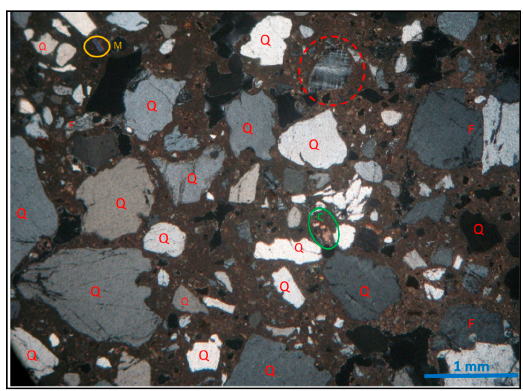
Figure 7. Micrography of sample S-004 (2.5×). Mineral abbreviations: Q: quartz; C: calcite; F: feldspar; M: muscovite. The red dotted circle encloses a crystal of microcline (K-feldspar).